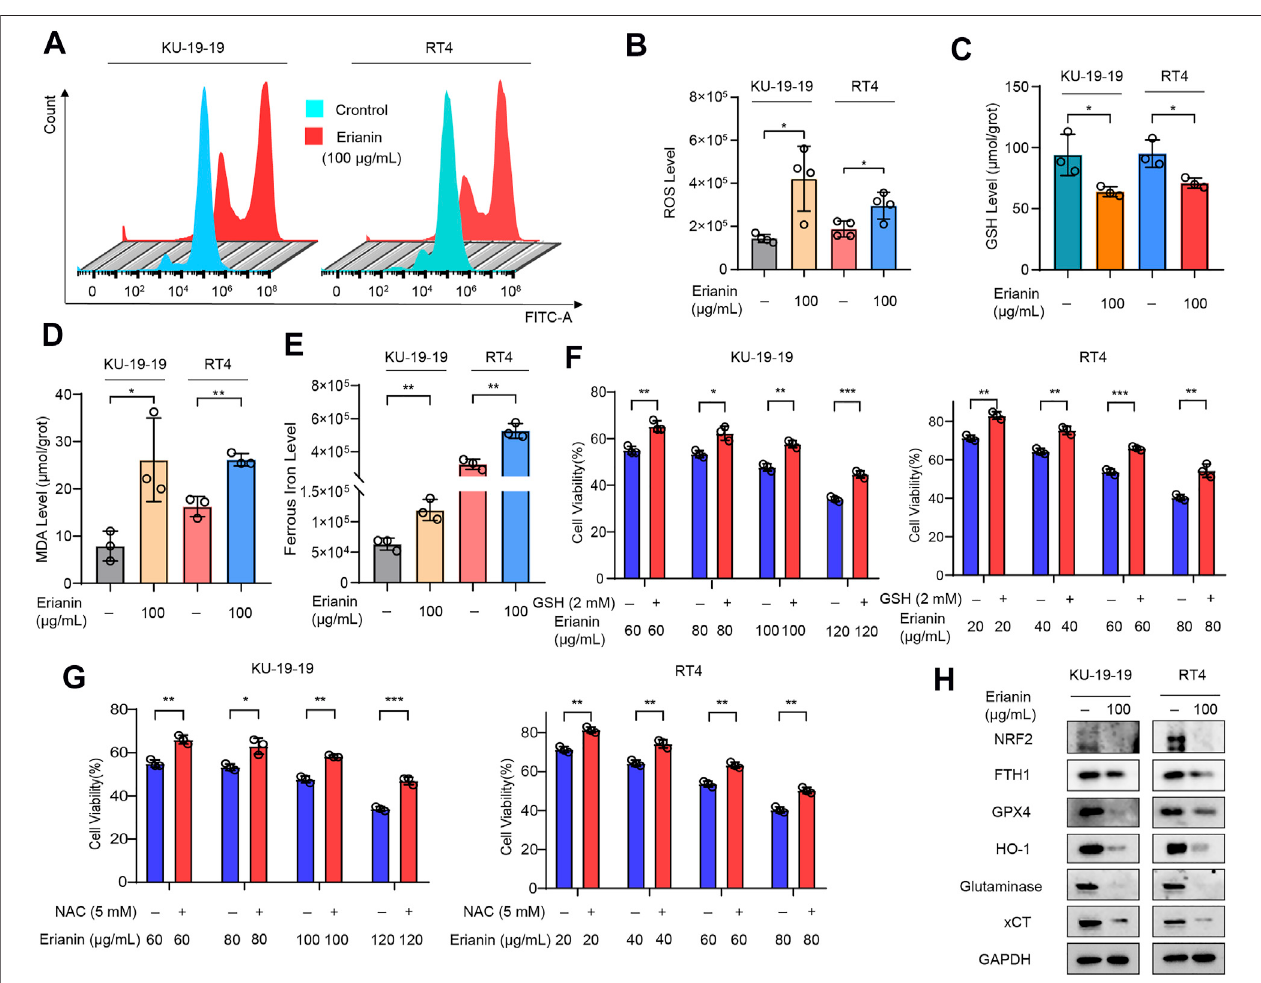
FIGURE 3 | Erianin triggered ferroptosis in bladder cancer cells. (A,B) KU-19 – 19 and RT4 cells were treated with erianin for 24 h and ROS level was analyzed by a fl ow cytometer, the mean ± s.d. is shown. * p < 0.05. (C) The GSH level in KU-19 – 19 and RT4 cells was detected after the treatment with erianin for 24 h, * p < 0.05. (D) The MDA level in KU-19 – 19 and RT4 cells was detected after the treatment with erianin for 24 h, * p < 0.05,** p < 0.01. (E) The iron level in KU-19 – 19 and RT4 cells was detected after the treatment with erianin for 24 h, ** p < 0.01. (F) KU-19 – 19 and RT4 cells were treated with erianin with or without the oxygen-derived free radicals scavengerGSHfor24 h,andcellviabilitywasassayed,** p < 0.01,*** p < 0.001. (G )KU-19 – 19andRT4cellsweretreatedwitherianinwithorwithouttheROSscavenger NAC for 24 h, and cell viability was assayed, ** p < 0.01, *** p < 0.001. (H ) Several ferroptosis related proteins were determined by western blotting.